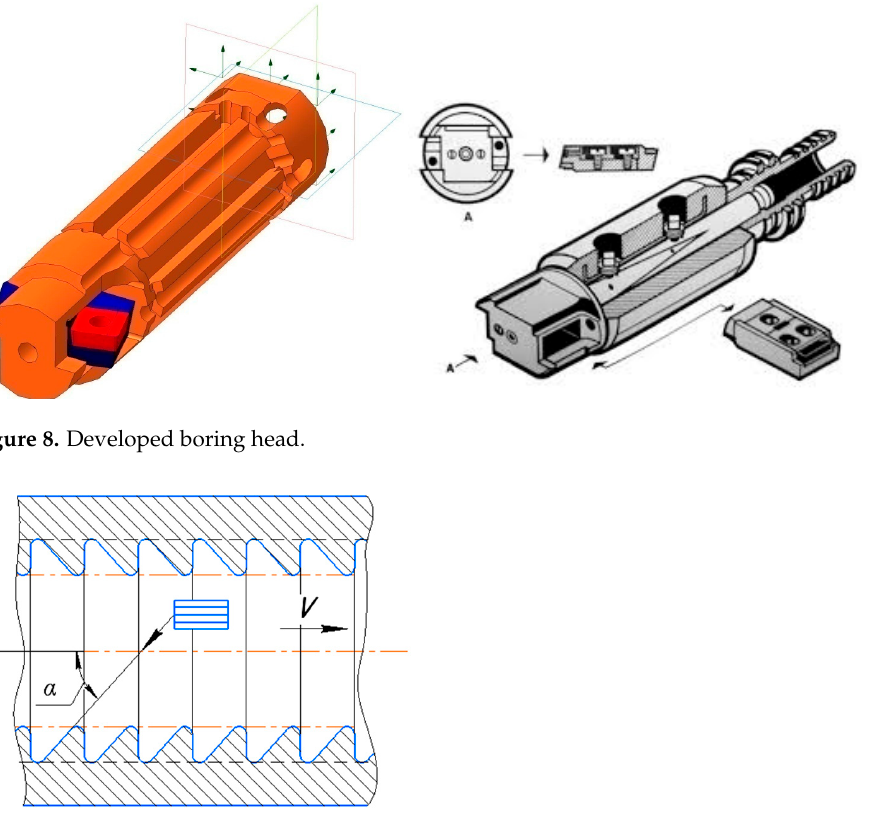
Figure 9. Location of the laser head nozzle in the pump cylinder.